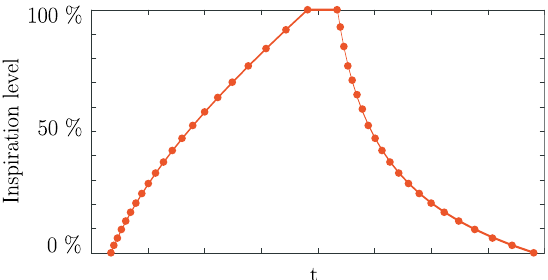
Fig.3: Breathing cycle for the simulation of ventilation. The conductivity of the lungs was simulated on 21 levels between fully deflated and fully inflated.